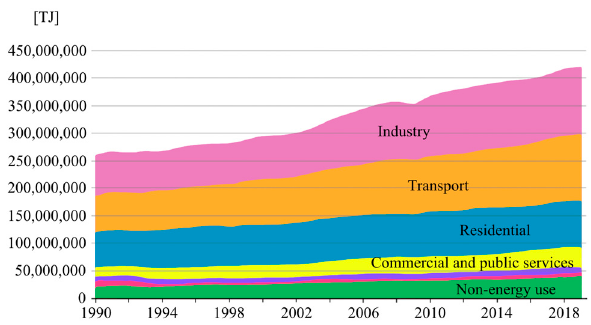
Figure 1. Total final consumption per sector, world [1].